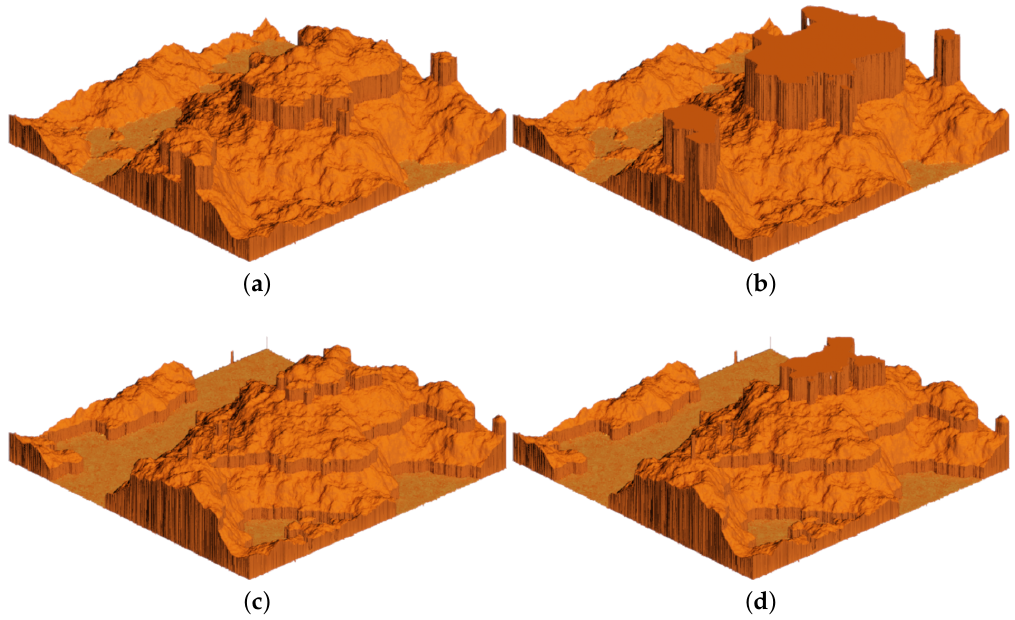
Figure 12. Comparison of the caprock impact on the sample mesa model shown in Figure 8. Erosive model was obtained for E = 0.5. ( a ) mat = 3 without caprock. ( b ) mat = 3 with caprock. ( c ) mat = 5 without caprock. ( d ) mat = 5 with